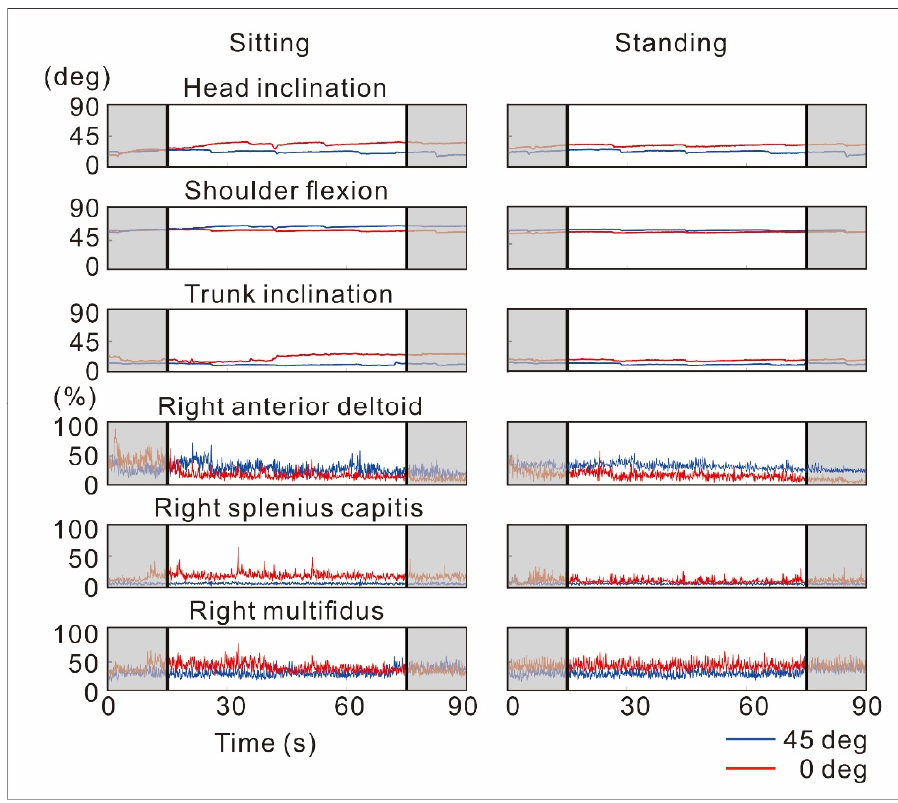
Figure 3. Segment and joint angles, and normalized EMG activities during the task in one participant. Data during 45 deg (blue lines) and 0 deg (red lines) tablet tilt conditions are shown separately for sitting (left column) and standing (right column) conditions. The upper three rows show segment and joint angles (deg). The bottom three rows show normalized EMG activities (%). Data of the first and last 15 s (gray-shaded area separated with black vertical lines) were excluded from the analysis.